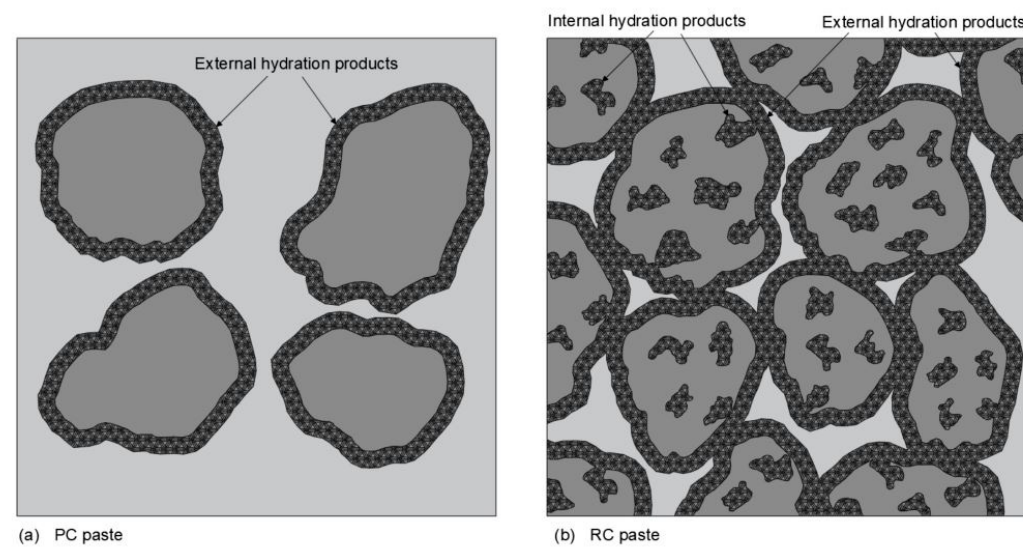
Figure 18. Schematic representation of microstructure development in PC and RC pastes.